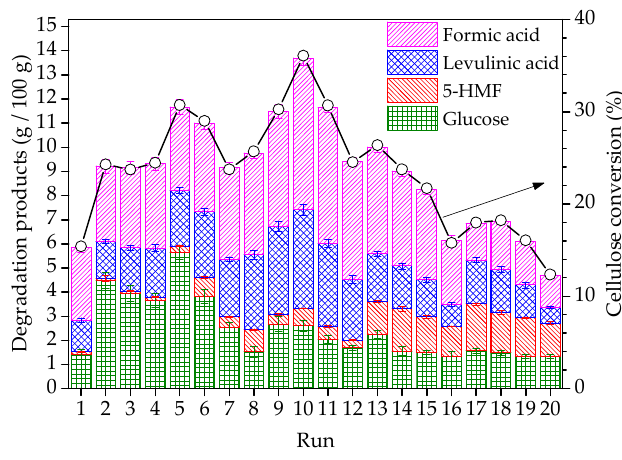
( c ) Figure 4. SEM images (at a 500 magnification) of untreated straw and the pretreatment samples by distilled water and FeCl 2 at 180 °C and 10 min. ( a ) untreated corn straw; ( b ) pretreated with distilled water; ( c ) pretreated with 1 × 10 − 5 mol/L FeCl 2 . 3.2. Effect of an Ultra-Low Concentration of FeCl 2 on Cellulose Hydrolysis Figure 5 exhibits the effect of 1 × 10 − 5 mol/L FeCl 2 pretreatment on cellulose degradation with four products, including glucose, 5-HMF, levulinic acid, and formic acid [49]. As seen in Figure 5, when CS was low between − 3.08 and − 2.14, more glucose was obtained and the content of glucose reached the maximum value of 5.7 g at 180 °C and 10 min. Meanwhile, cellulose degradation also reached the highest value of 36.06%. By comparison, the degradation of cellulose was not more than